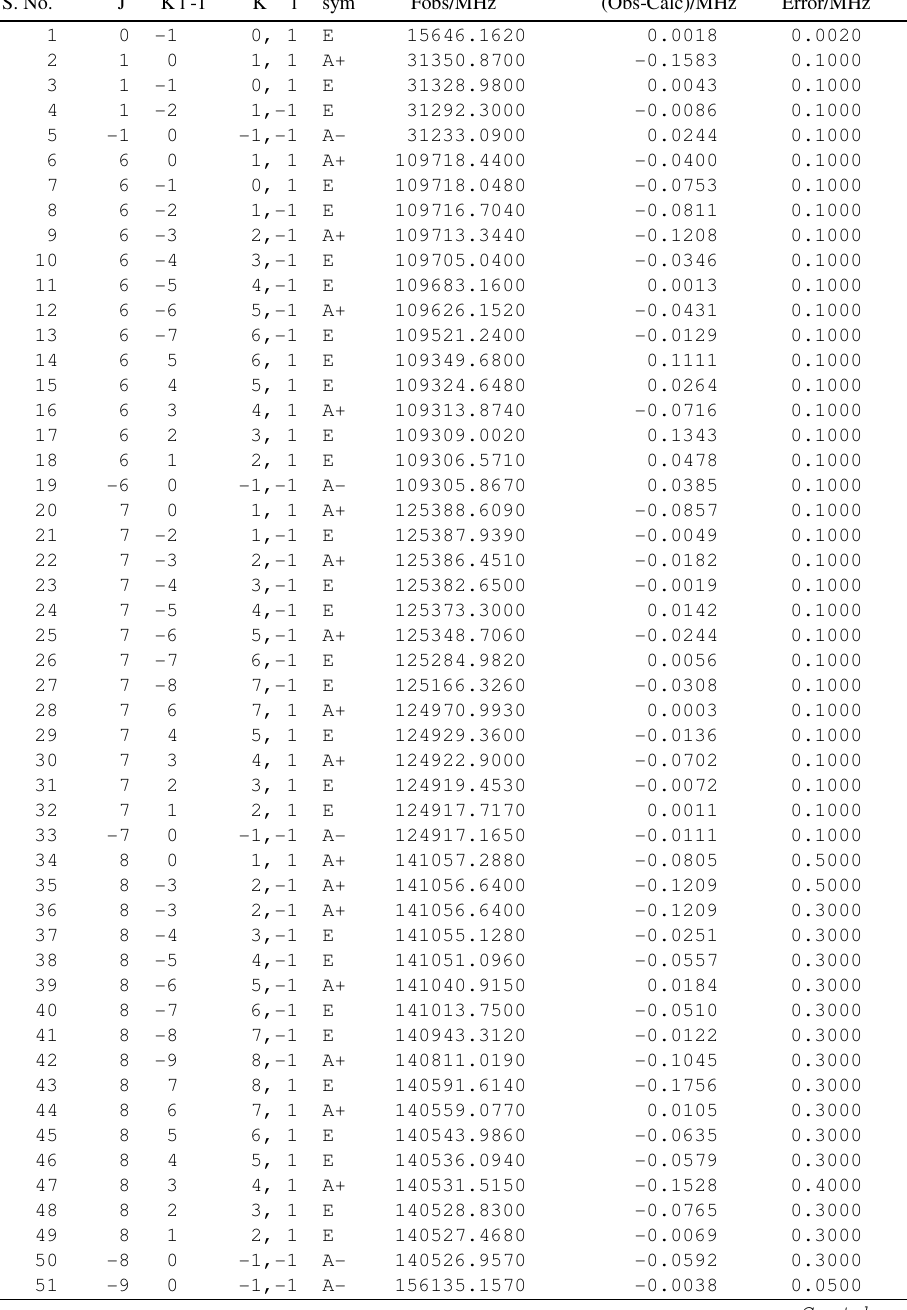
in v = 1 State 3 4